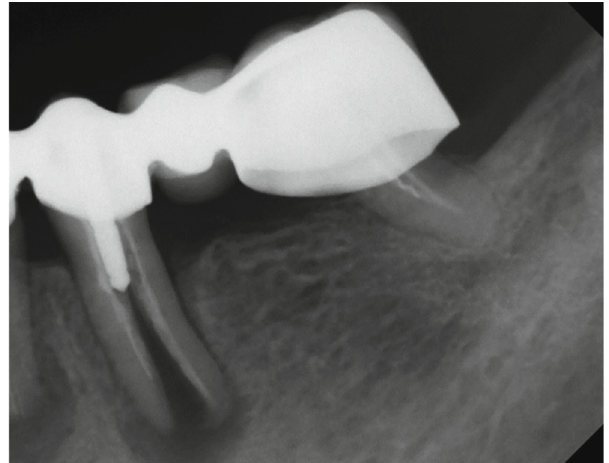
Figure 1: Radiograph tooth 35 at intake August 2018.